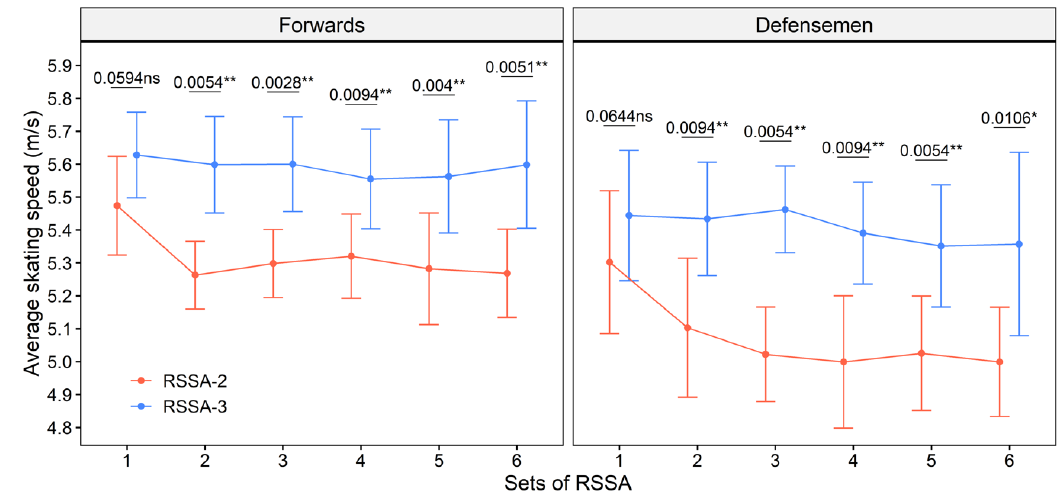
Figure 2. Average skating speed of the forwards and defensemen in RSSA-2 and RSSA-3 tests (ns—non-significant, * p < 0.05; ** p < 0.01).